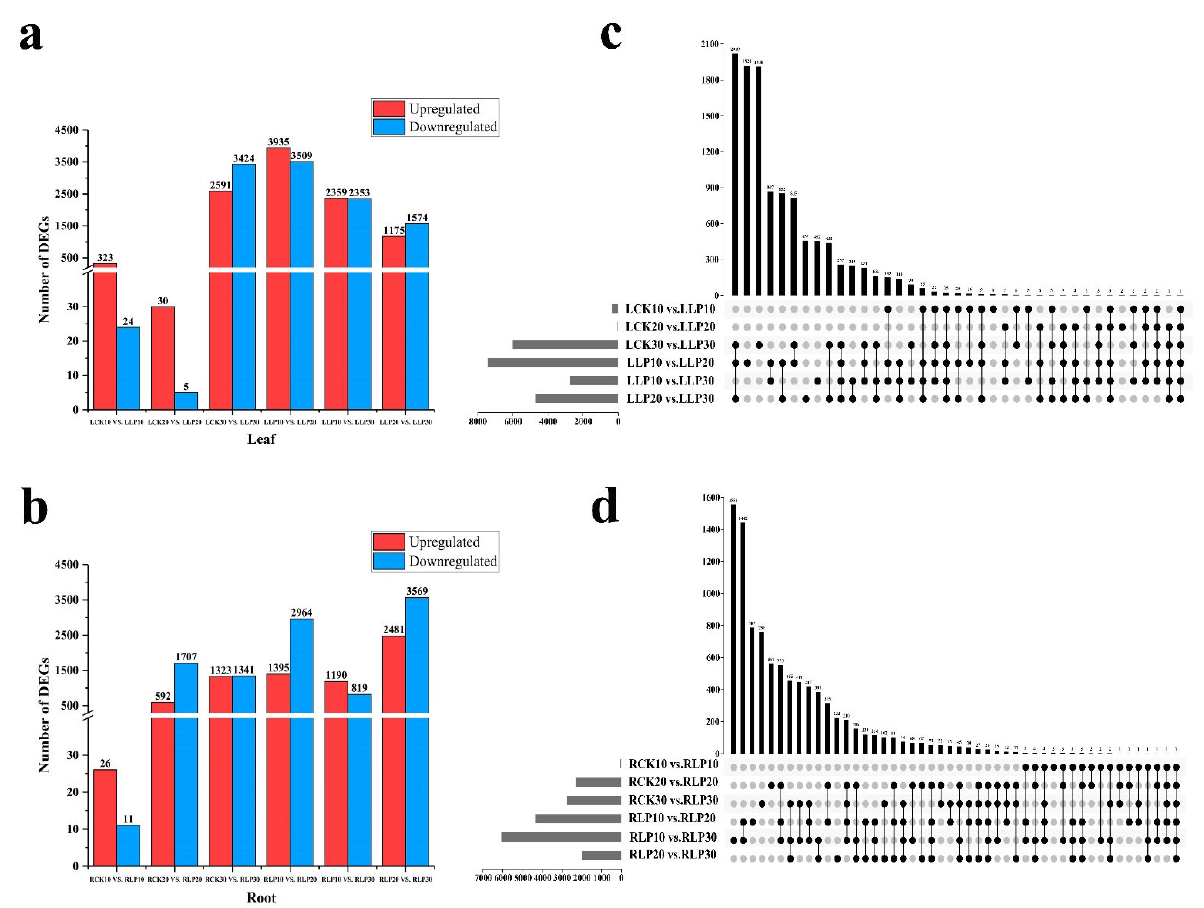
Figure 4. DEGs of under low − Pi stress. Statistics of up − and down − regulated DEGs in leaves ( a ) and roots ( b ) for each pairwise comparison. Venn diagrams of DEGs for control and low − Pi are in leaves ( c ) and roots ( d ). Red represents the DEGs number that is up − regulated, and blue represents the DEGs number that is down − regulated. The x − axis represents the difference comparison scheme for each group, and the y − axis represents the number of corresponding differential genes (DEGs).